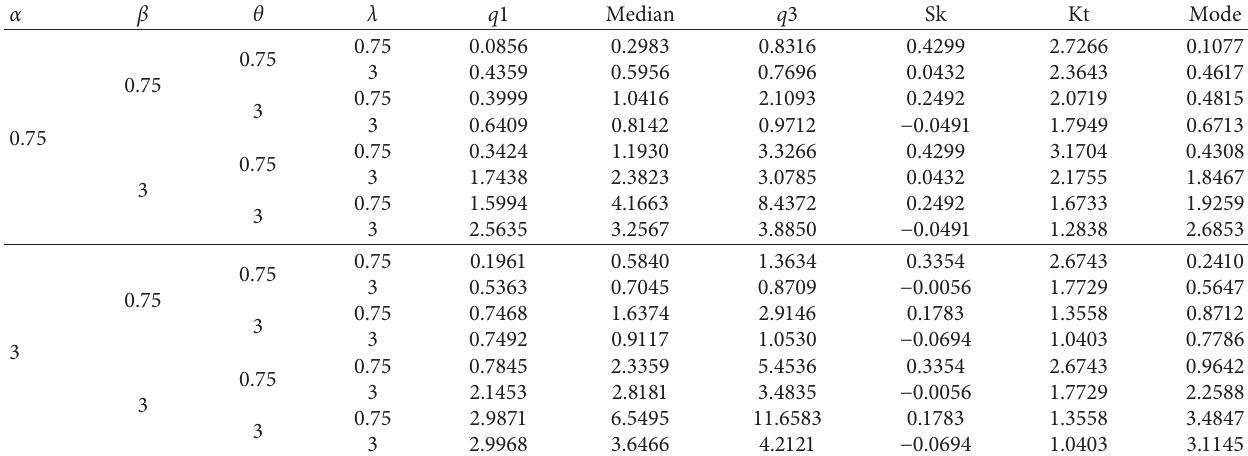
Table 2: The first and third quartile, median, skewness, kurtosis, and mode of MOAPW distribution with different values of the parameters. α β θ λ q 1 Median q 3 Sk Kt